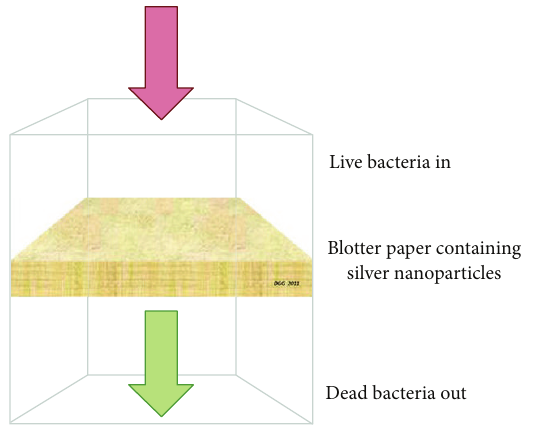
Figure 1: Schematic presentation of the disinfection process of blotter paper containing silver nanoparticles. Reprinted from [19] with permission. Copyright © 2011, American Chemical Society.